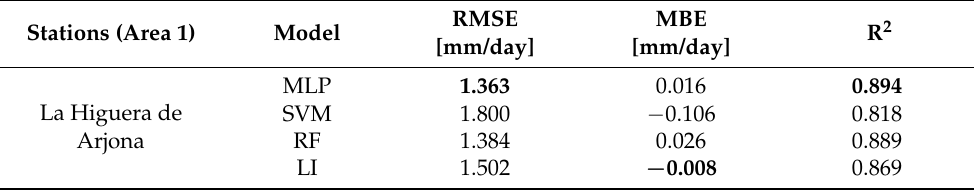
Table 4. RMSE, MBE, and R 2 performance values from testing dataset for all locations and models in the first area (inland locations), using data from neighbor stations. The best values for each site are in